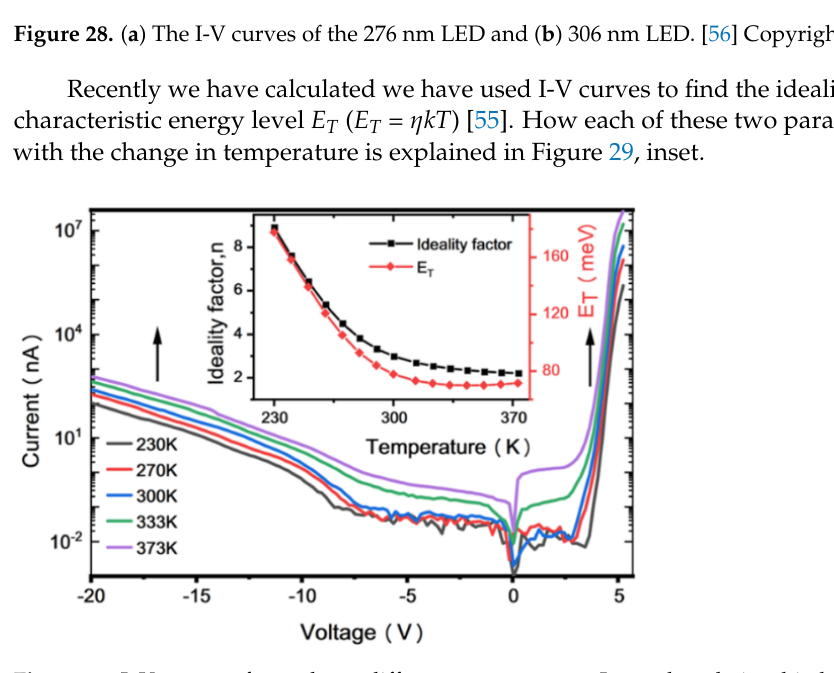
Figure 29. I–V curves of samples at different temperatures. Inset: the relationship between η and E T with temperature. [55] Copyright 2022, AIP.